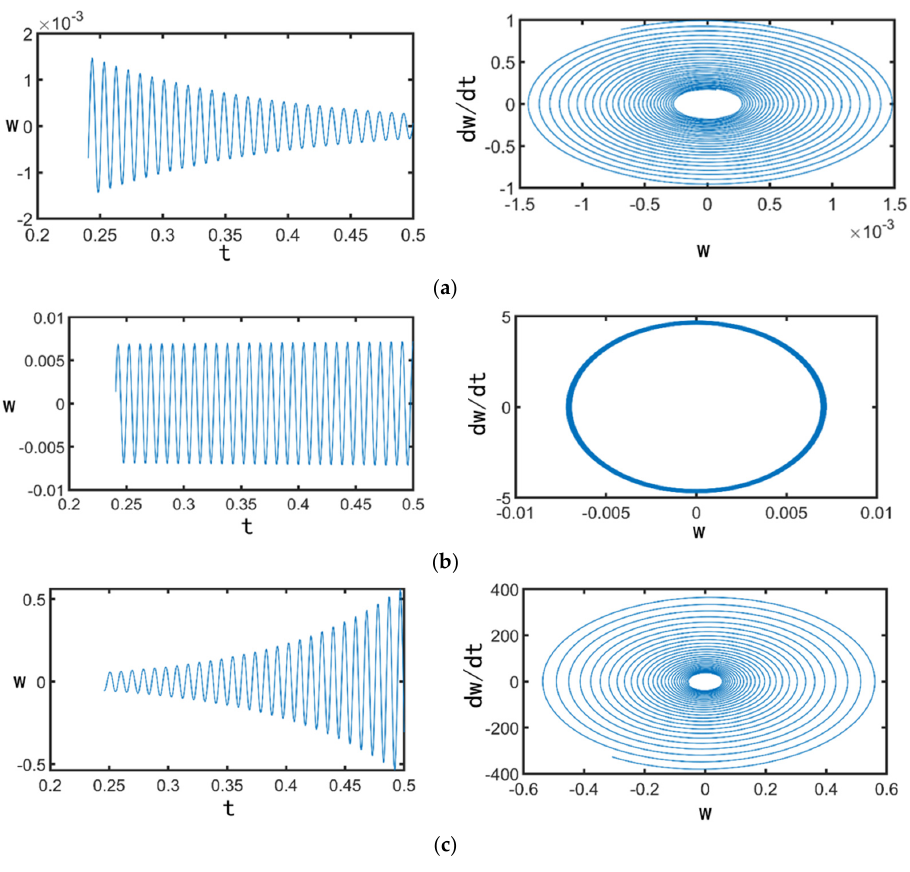
Figure 6. The waveform and phase diagrams under different flow pressures. ( a ) P ∞ = 1310 kpa, ( b ) P ∞ = 1341 kpa, ( c ) P ∞ = 1351 kpa. Table 9. Flow pressures with wall thickness change.